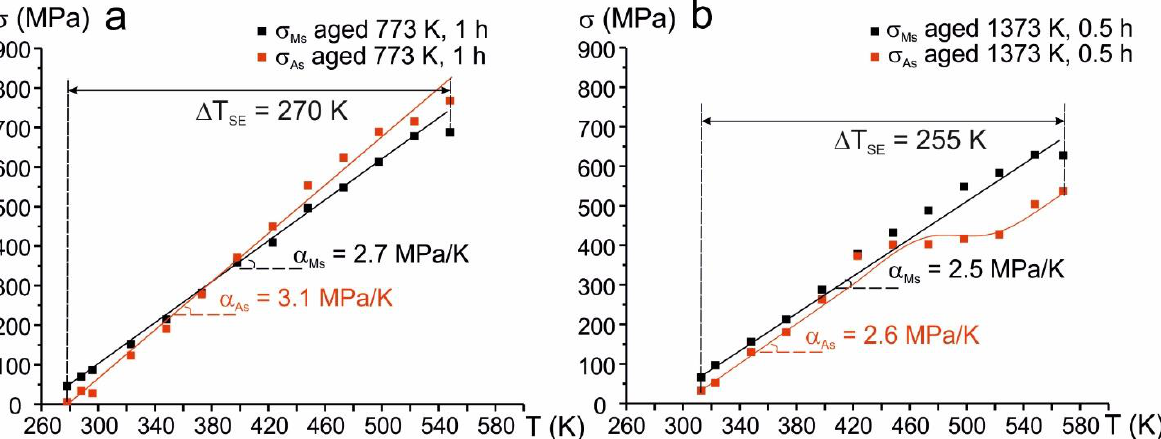
Figure 5. The temperature dependence of the critical stresses of forward σ Ms and reverse σ As MT for [001]-oriented Ni 54 Fe 19 Ga 27 single crystals aged at 773 K for 1 h ( a ) and at 1373 for K 0.5 h ( b ).